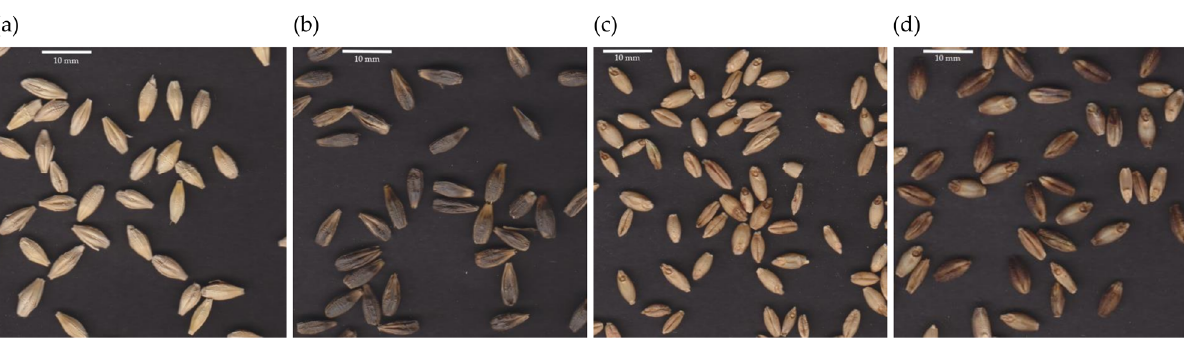
Figure 1. Map of barley accessions stored at the National Center of Plant Gene Resources that have landrace status and were covered by DArTseq-based SNP analysis, highlighted in blue.